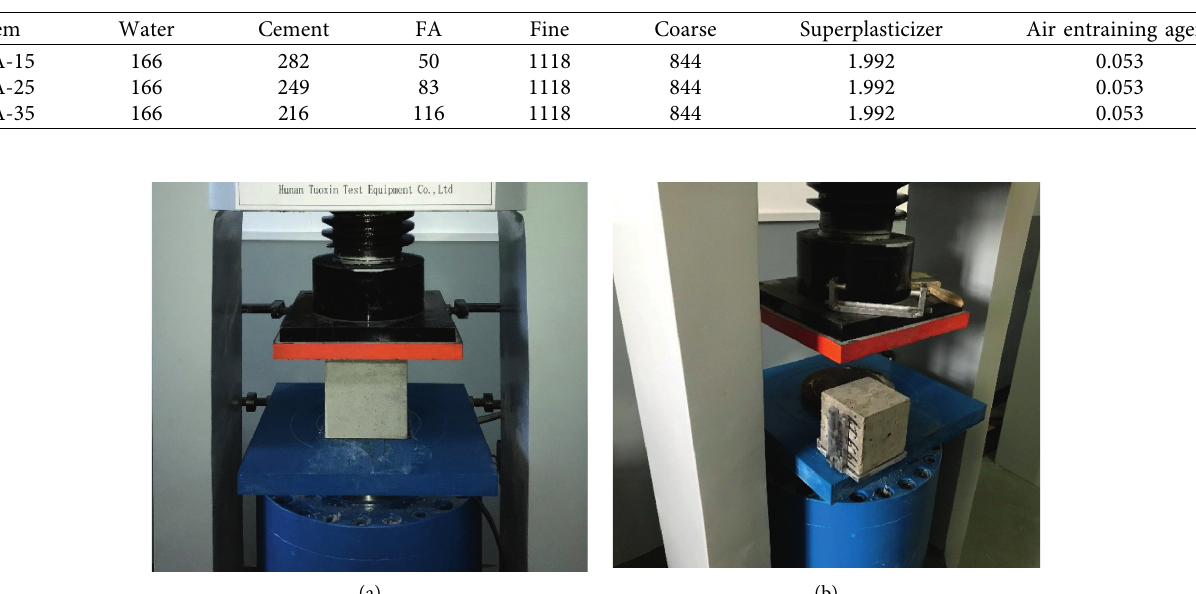
Table 3: Mix proportion of concrete (kg/m 3 ).